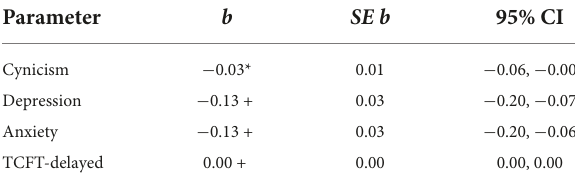
TABLE 5 Linear mixed model analysis of perceived family support as a predictive factor ( N =